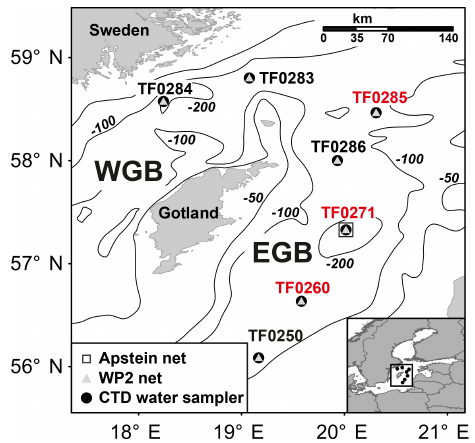
Figure 1. Map of sampling stations in the western Gotland Basin (WGB) and the eastern Gotland Basin (EGB). Symbols describe the sampling gear. Stations with a distinct subthermocline methane enrichment are marked in